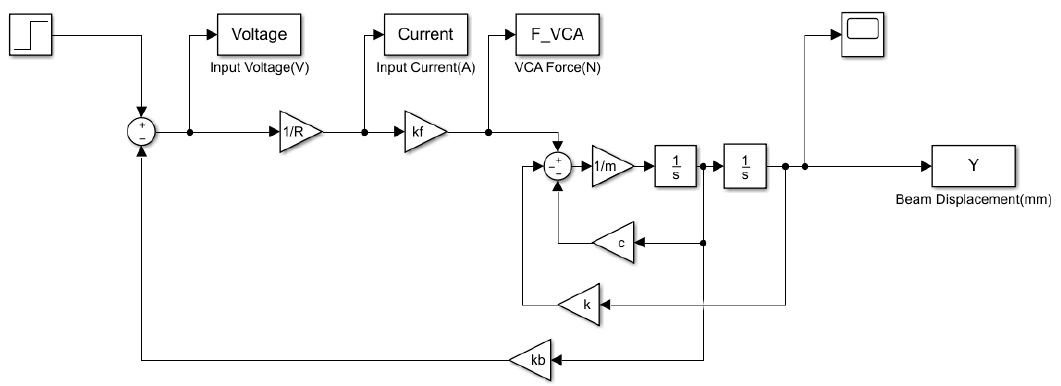
Figure 11. Simulink model of voice coil actuator.